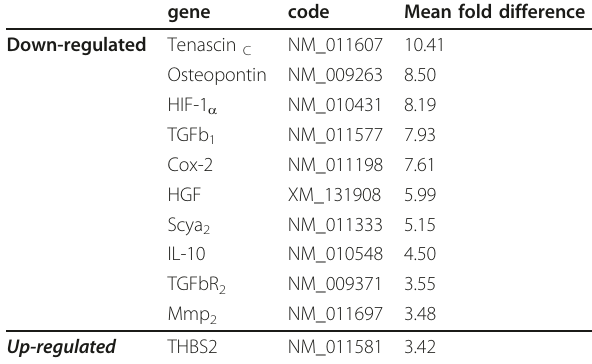
Affected by Sal B in CAL27 cells gene code Mean fold difference